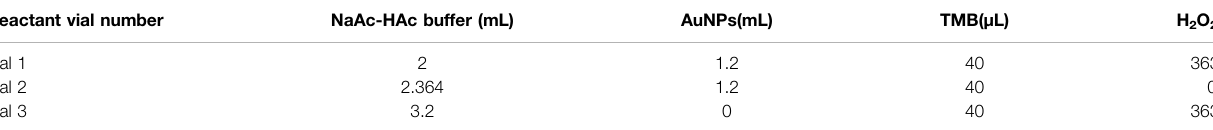
TABLE 2 | Nano-enzyme activity determination veri fi